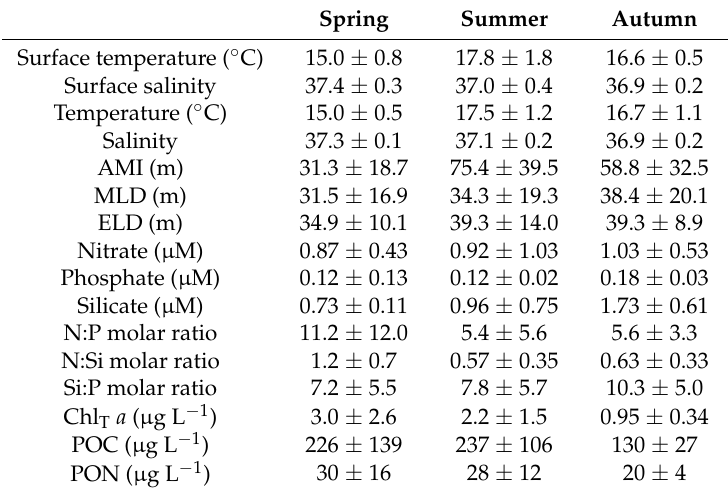
Table 2. Seasonal mean ± standard deviation of the different variables estimated in the euphotic layer. Data correspond to the average value obtained during 2012/03, 2014/04 and 2015/04 for spring, 2010/07, 2012/07, and 2014/06 for summer, and 2011/11, 2012/11, and 2014/11 for autumn. AMI: Atlantic–Mediterranean interface depth; MLD: mixed layer depth; ELD: euphotic layer depth; Chl T a , total chlorophyll a ; POC and PON, particulate organic carbon and nitrogen, respectively. Spring